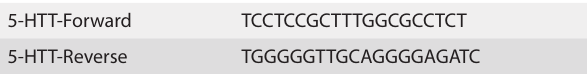
Table 4. Sequence of primers used for the amplification of the 5-HTTLPR (BioneerR).